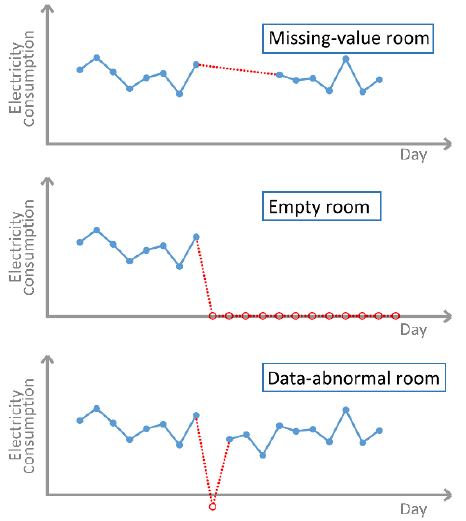
Figure 4. Identification of the missing-value rooms, empty rooms and data-abnormal rooms.